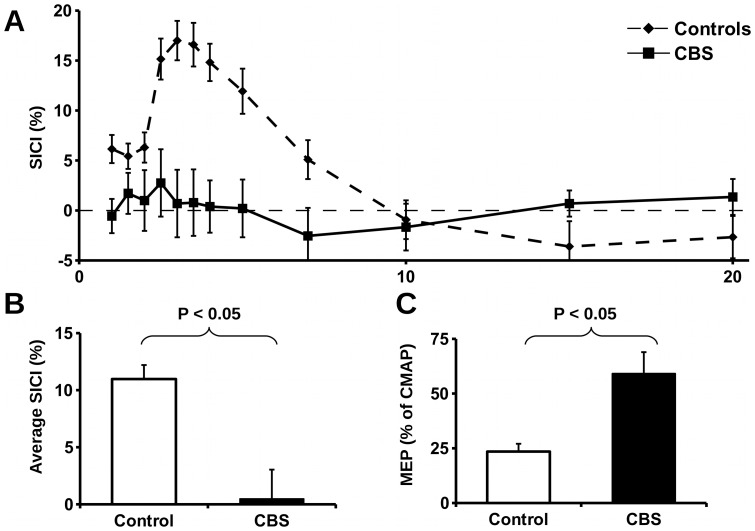
Cortical hyper-excitability in corticobasal syndrome.Patients with CBS had evidence of cortical hyper-excitability, with reduced SICI (A), significantly (P<0.05) reduced average SICI (B), and significantly (P<0.05) increased motor evoked potential – expressed as a ratio of compound motor action potential amplitude (C). Abbreviations: CBS  =  corticobasal syndrome, SICI  =  short-interval intracortical inhibition, MEP  =  motor evoked potential, CMAP  =  compound motor action potential.